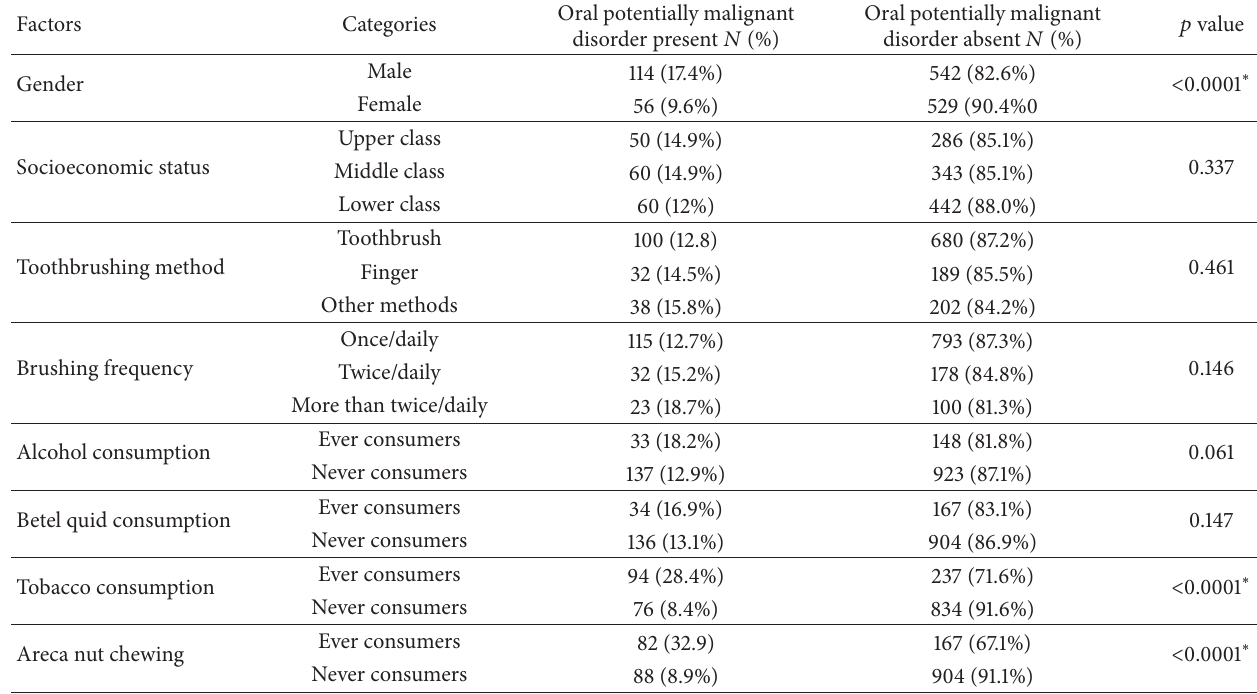
Table 3: Association of socio demographic characteristics, oral hygiene practices and adverse oral habits with oral potentially malignant